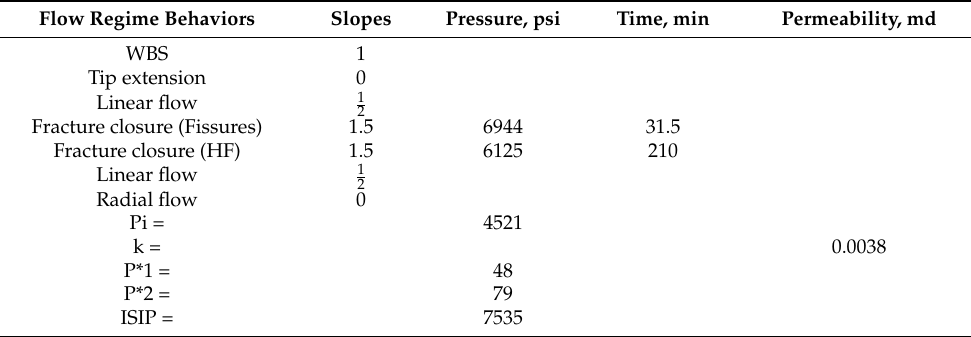
Table 12. Summary of the main DFIT outcomes of the Meramec Formation for W2.